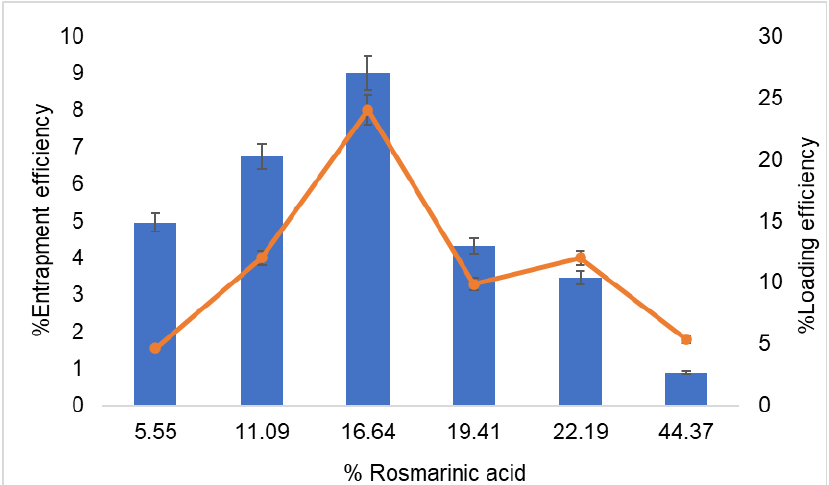
Figure 2. Effect of rosmarinic acid concentration (% per lipid weight) on the % entrapment efficiency ( ) and loading efficiency ( - ). Each value represents the mean ± standard deviation ( n = 3).